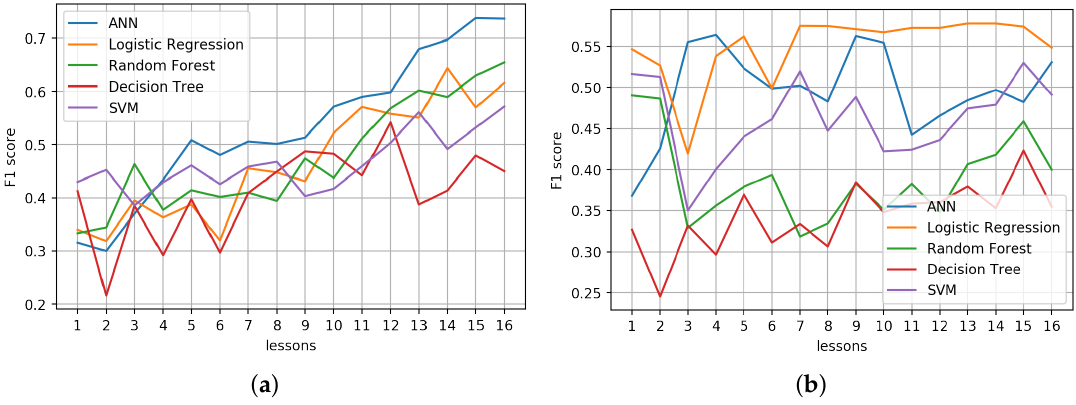
Figure 8. F1 score comparison of all models across 16 lessons. ( a ) With comment information; ( b ) Without comment information.